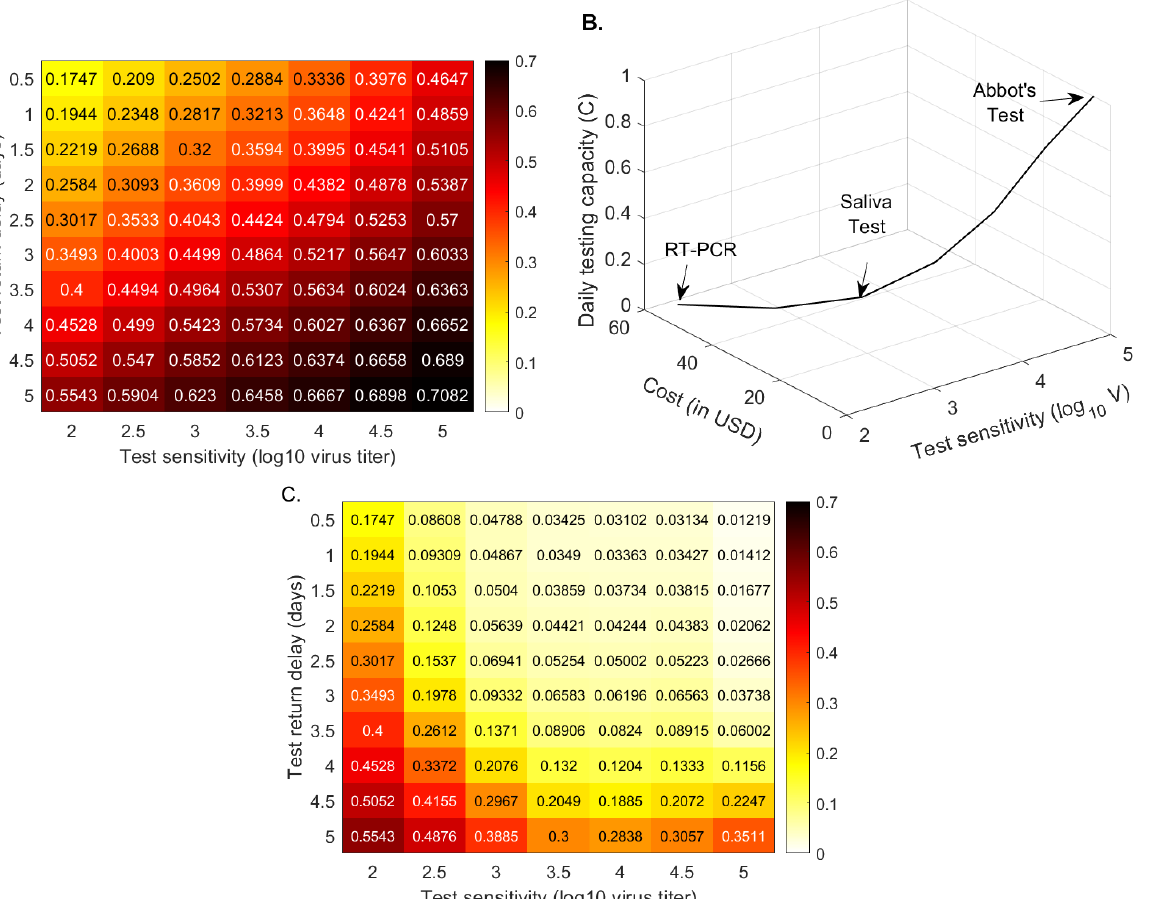
Figure 3. Cumulative cases (as proportion of the total population) at half a year. Heatmaps for the cumulative cases (as proportion of the total population) at half a year after the outbreak (% of the total population) as given by model Equation (5) versus test sensitivity and test return delay. Panel ( A ): fixed testing capacity per day, C = 0.1. Panel ( B ): relationship between capacity and cost. Panel ( C ): fixed testing budget per day. Parameters and initial conditions are given in Tables 1 and